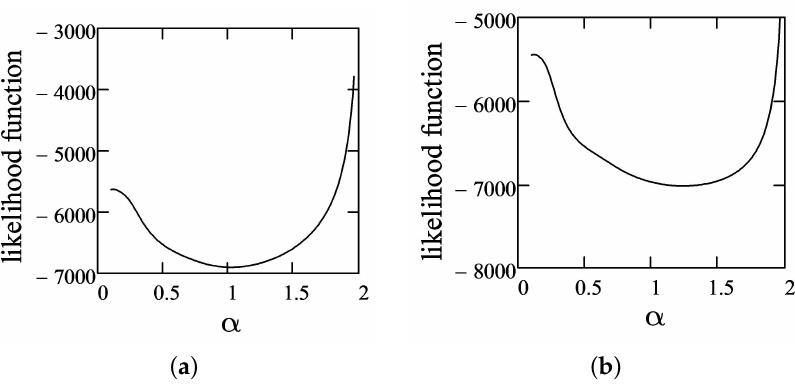
Figure 8. LLF dependence on α : ( a ) at the first iteration; and ( b ) at the last iteration. Using the EM algorithm, the LLF value and parameter estimates were registered for quickly (see Figure 9).